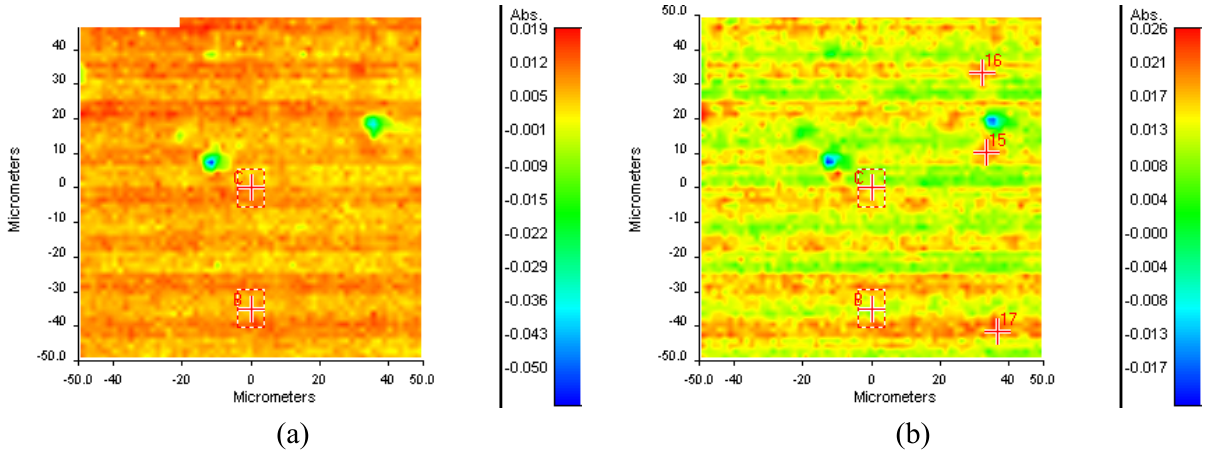
Figure 5. Confocal fluorescence microscopy images of non-modified PI ( a ) and texas red-labelled gelatin-coated PI ( b